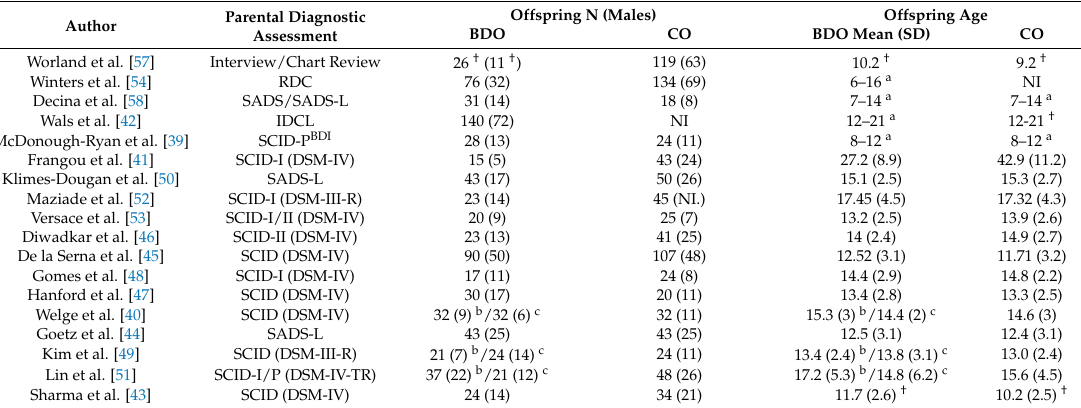
Table 1. Studies of Bipolar Offspring-Demographic Characteristics of BDO and